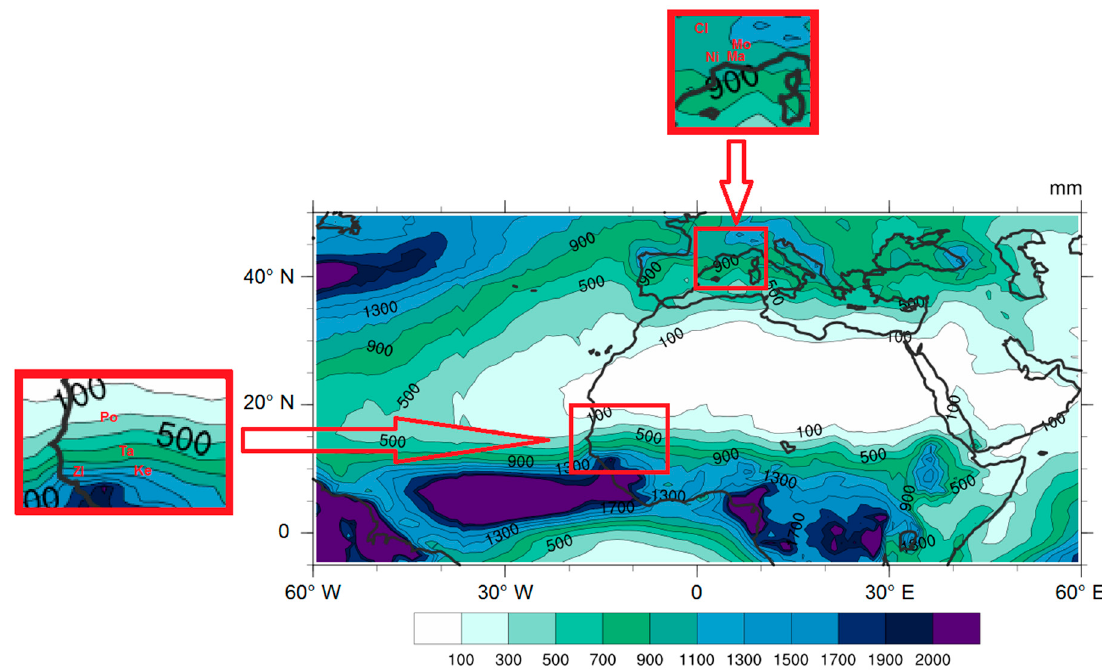
Figure 3. Average annual cumulative rainfall between 1998 and 2008 from GPCP data in mm/day, with the geographical location of mid-latitudes sites in France (Clermont–Cl, Montélimar–Mo, Nîmes–Ni and Marignane–Ma) and Sahelian sites in Senegal (Podor–Po, Tambacounda–Ta, Ziguinchor–Zi and Kedougou–Ke).